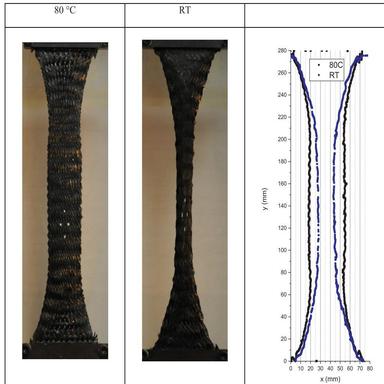
Pictures of test-specimens to the end of test (65 mm displacement) at RT and 80 °C together with overlapping outer contours of the specimen to estimate the dimensional changes in the specimen geometry of CEP-TW1 prepreg.